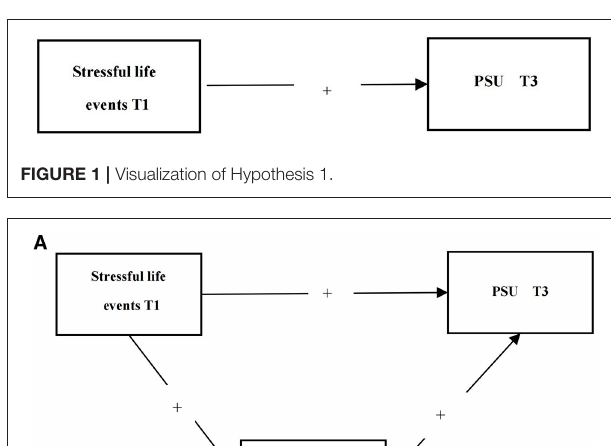
that depressive symptoms at T2 would mediate the positive relationships between stressful life events at T1 and PSU at T3 (Hypothesis 2a), and also proposes sleep quality at T2 would mediate the relationship between stressful life events at T1 and PSU at T3 (Hypothesis 2b), as well as suicidal ideation at T2 would mediate the relationships between stressful life events at T1 and PSU at T3 (Hypothesis 2c). Figure 2 presents Hypotheses 2a, 2b, and